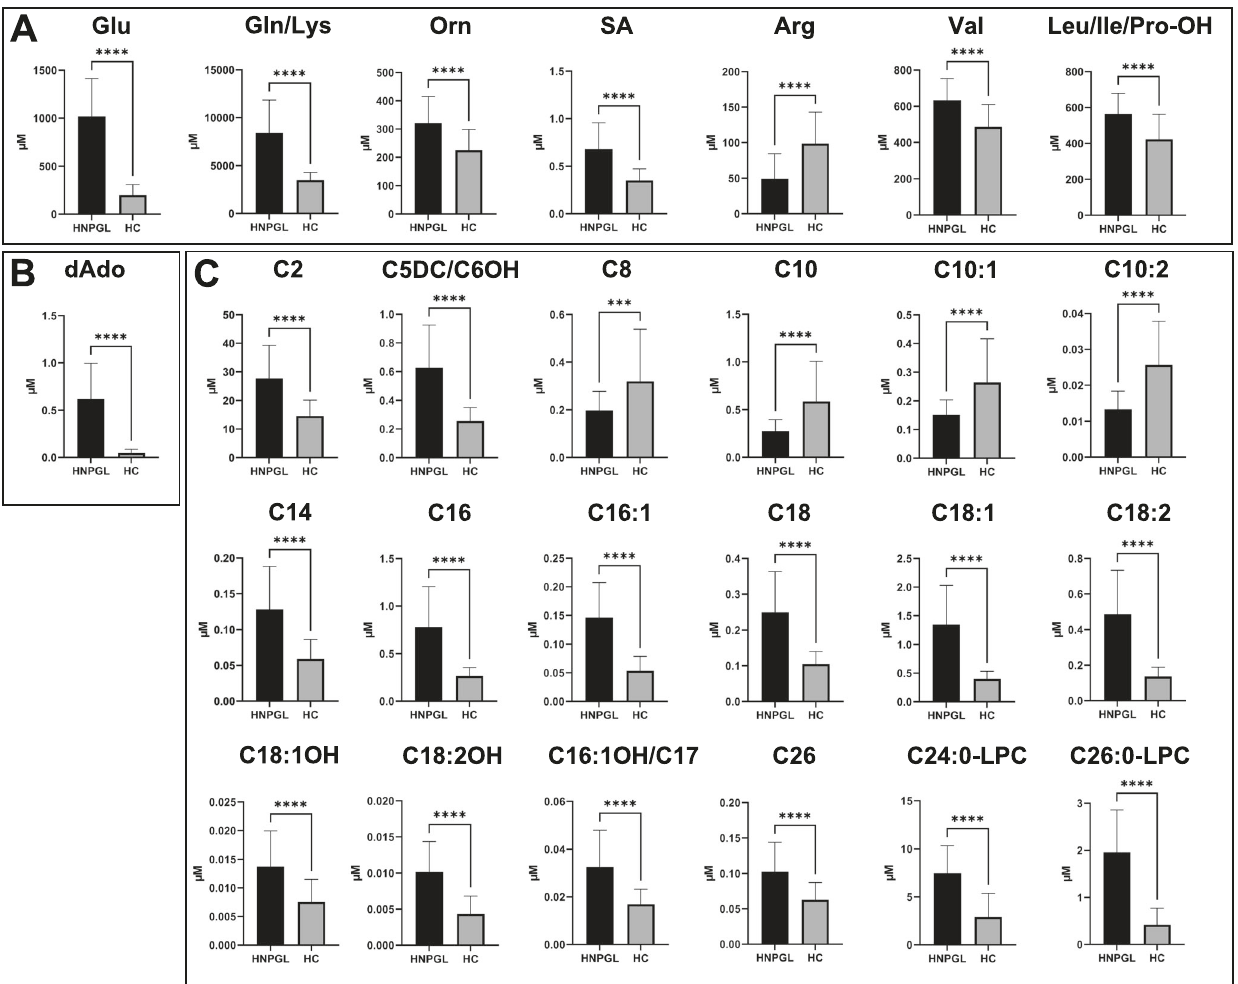
Fig. 2 Bar charts for the metabolites with VIP values > 1 in the head and neck paraganglioma patients (HNPGLs) versus the healthy controls (HCs). Data are presented for amino acids ( A ), adenosines ( B ), acyl-carnitines and lysophosphatidylcholines ( C ). Signi fi cance was established by t-test (*** p < 0.001; **** p <